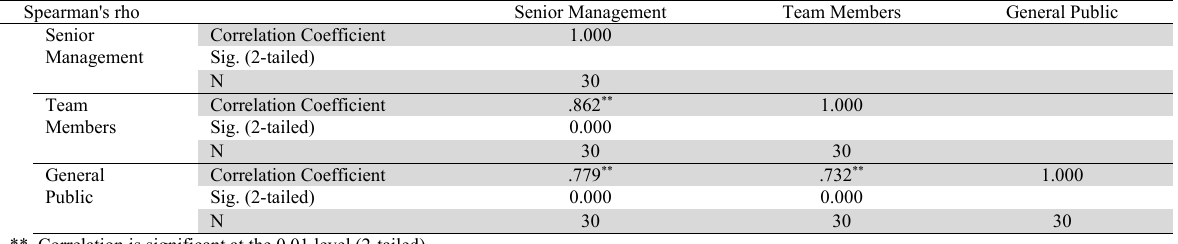
Spearman's Rank Correlation on the ranking of Failure Factors Spearman's